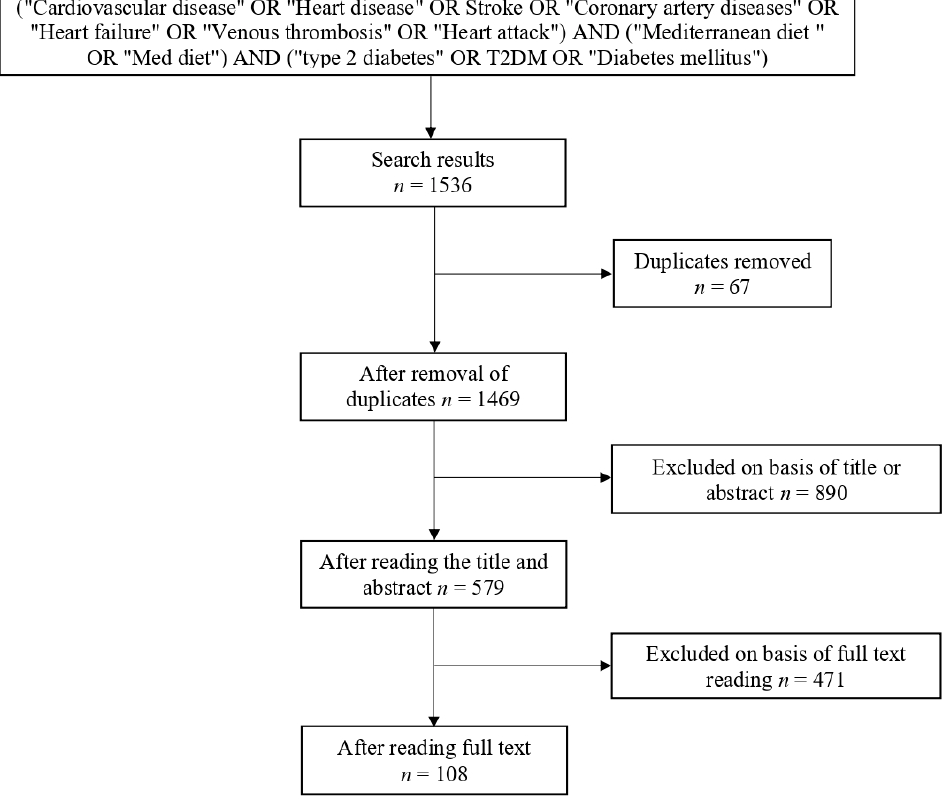
Figure 1. Flowchart of inclusion criteria, study selection, and search query.